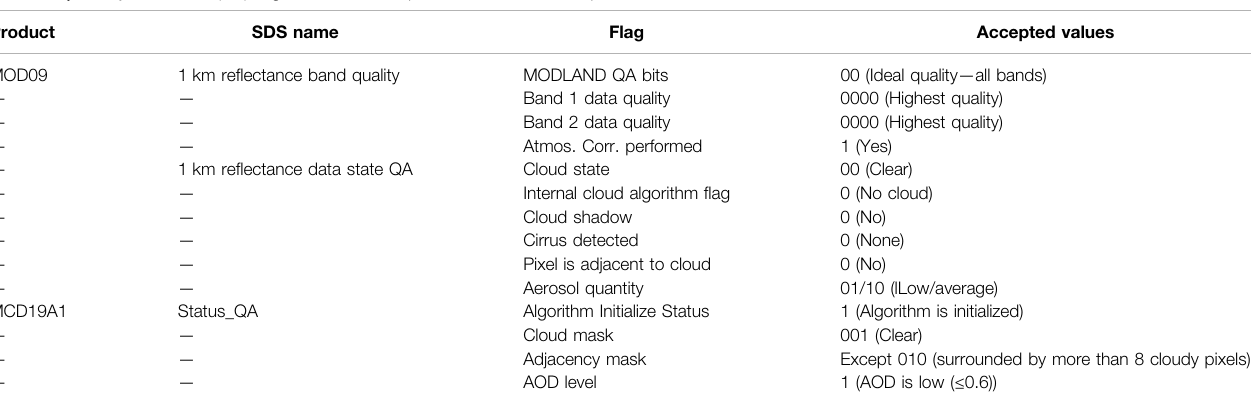
TABLE 1 | Quality Assurance (QA) fl ags of the MOD09 product and MCD19A1